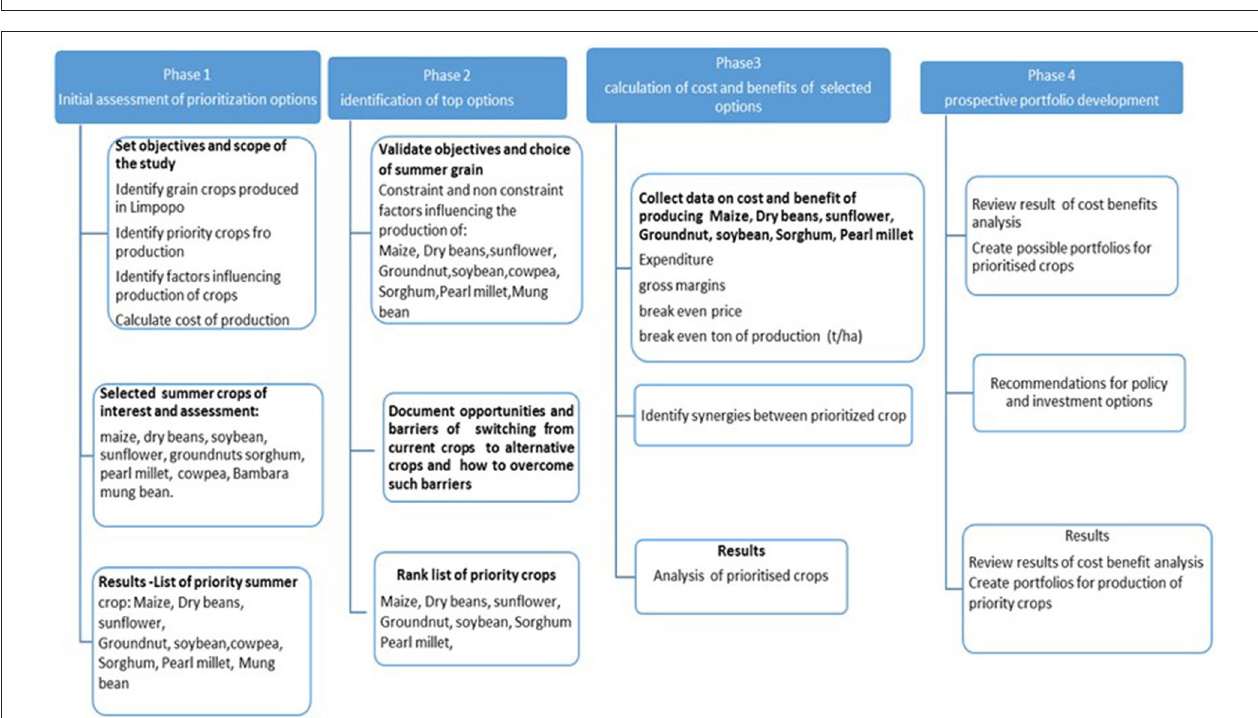
FIGURE 5 | A summary of the scale, objectives, and the approaches used in selecting crops.